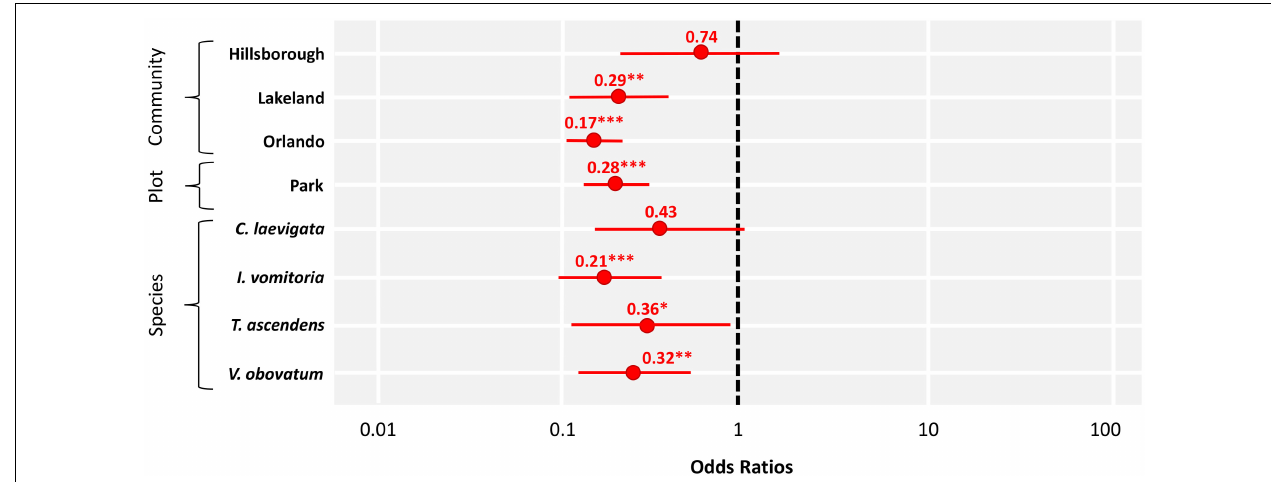
FIGURE 4 | Forest plot for the ordinal logistic regression, comparing against best performers in each category from the establishment trial. Scores from the cities/counties were compared against Pinellas County, trees in parks compared against trees along streets, and species against U. alata . The red dots represent the resulting odds ratios. The associated bars represent the corresponding 95% confidence intervals. An “ ∗ ” marks statistically significant variables ( ∗ P < 0.05; ∗∗ P < 0.01, ∗∗∗ P < 0.001). This analysis excludes trees that died by human-related